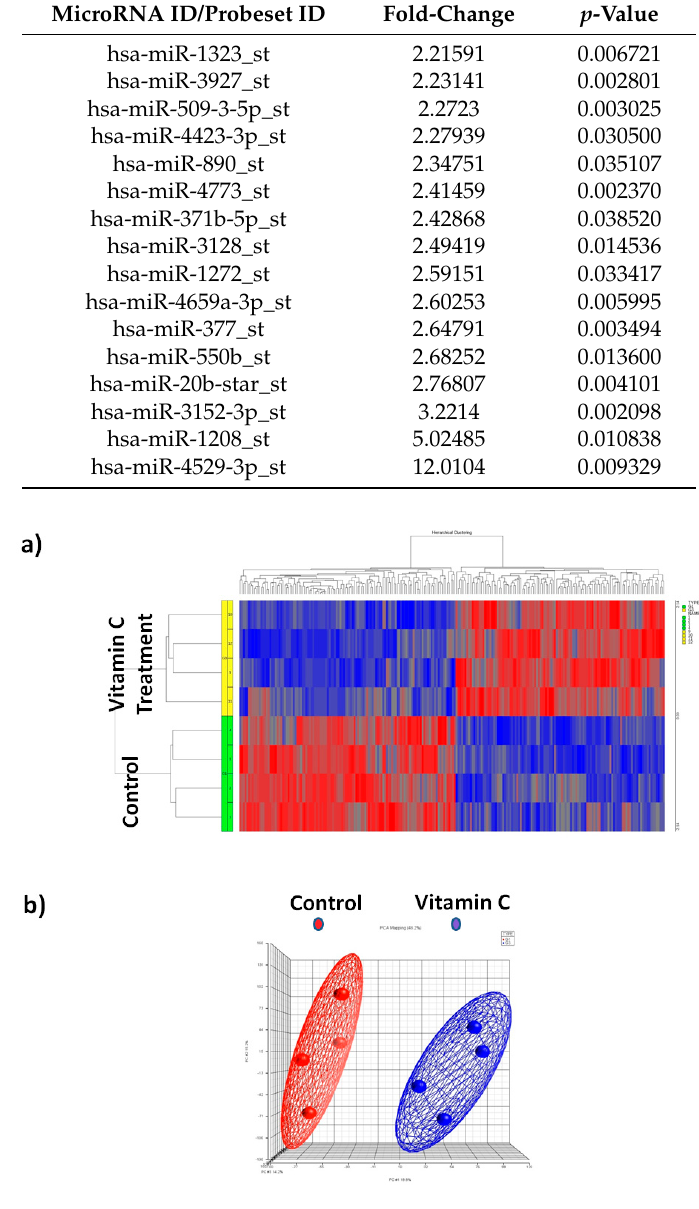
Figure 3. Differential miRNA expression in human bone marrow stromal cells after vitamin C treatment ( n = 4 each group). ( a ) The heat-map showing the differential expression pattern of miRNAs compared to control group; ( b ) Principle component analysis (PCA) mapping of vitamin C treatment and control samples. Control group (indicated by red color) was clustered distinctly from vitamin C treated group (indicated by blue color).